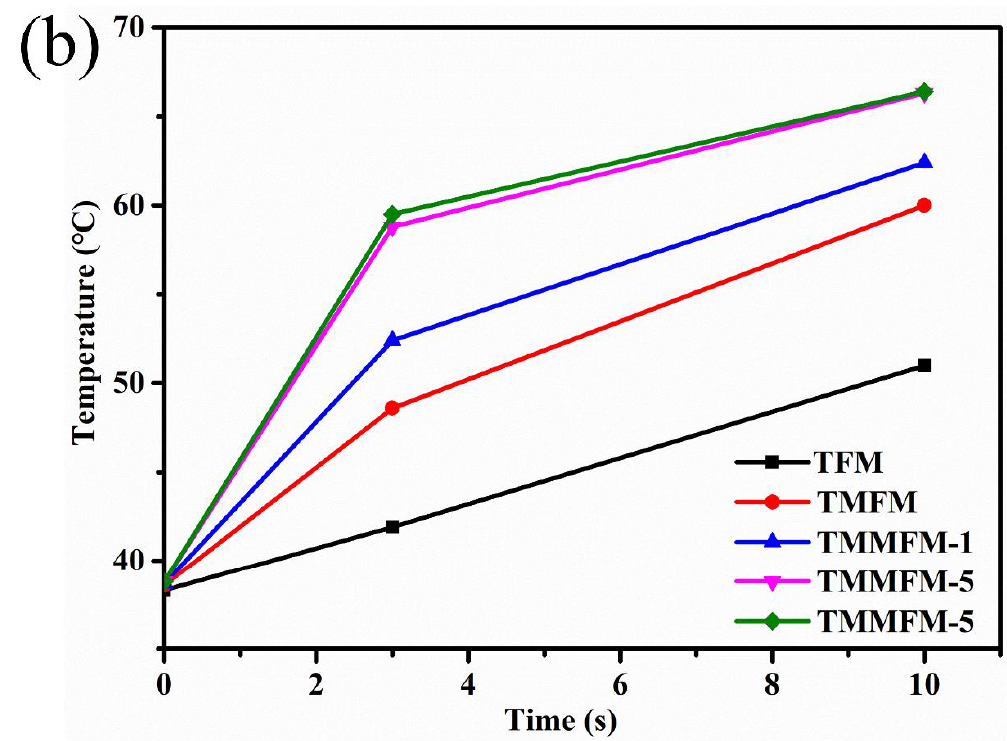
Figure 9. ( a ) Infrared thermal images of the TFM, TMFM and TMMFM. ( b ) Infrared thermal imaging temperature chart of TFM, TMFM and TMMFM.